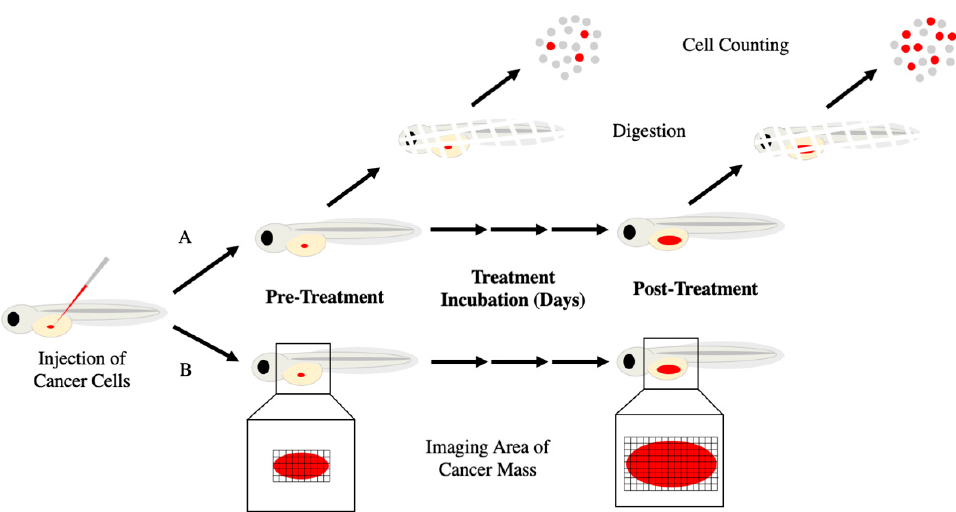
Figure 3. Methods of calculating cancer growth in zebrafish xenografts. Zebrafish embryos are engrafted with fluorescent cancer cells (red) by microinjection into the yolk sac and tumor progression is assessed in one of two ways. ( A ) Pre-treatment, a random subset of zebrafish is sacrificed, digested with collagenases, and fluorescent cells are counted. The remainder of the xenografts are exposed to treatment. After the treatment period, xenografts are digested, and cells are counted as before. Fold change in cell count reflects cancer growth/reduction. ( B ) Images are taken of the fluorescent cancer cells within the zebrafish at both pre- and post-treatment with fold change in area and fluorescent intensity indicating cancer growth/reduction.